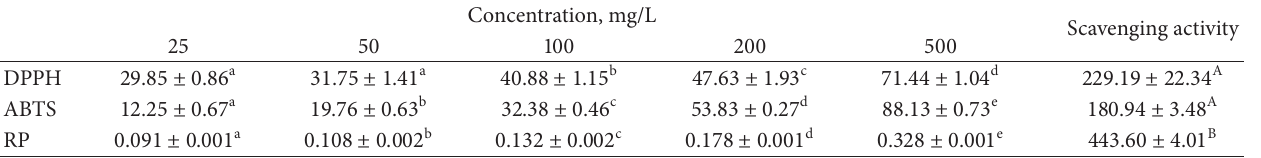
Table 4: Antioxidant activity (%).